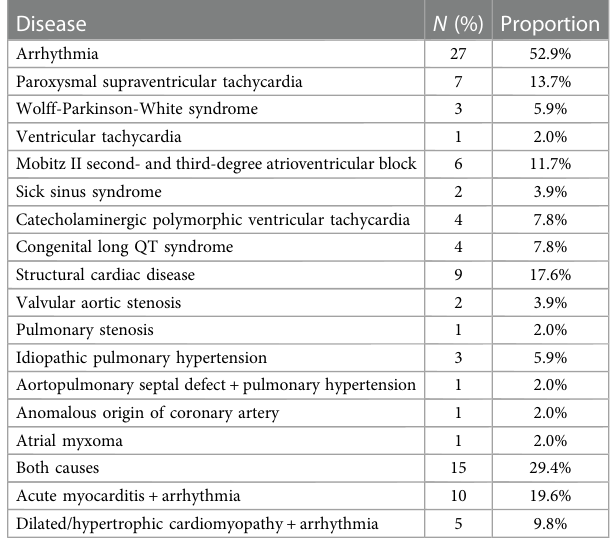
TABLE 3 The underlying disease of children with cardiac syncope. Disease